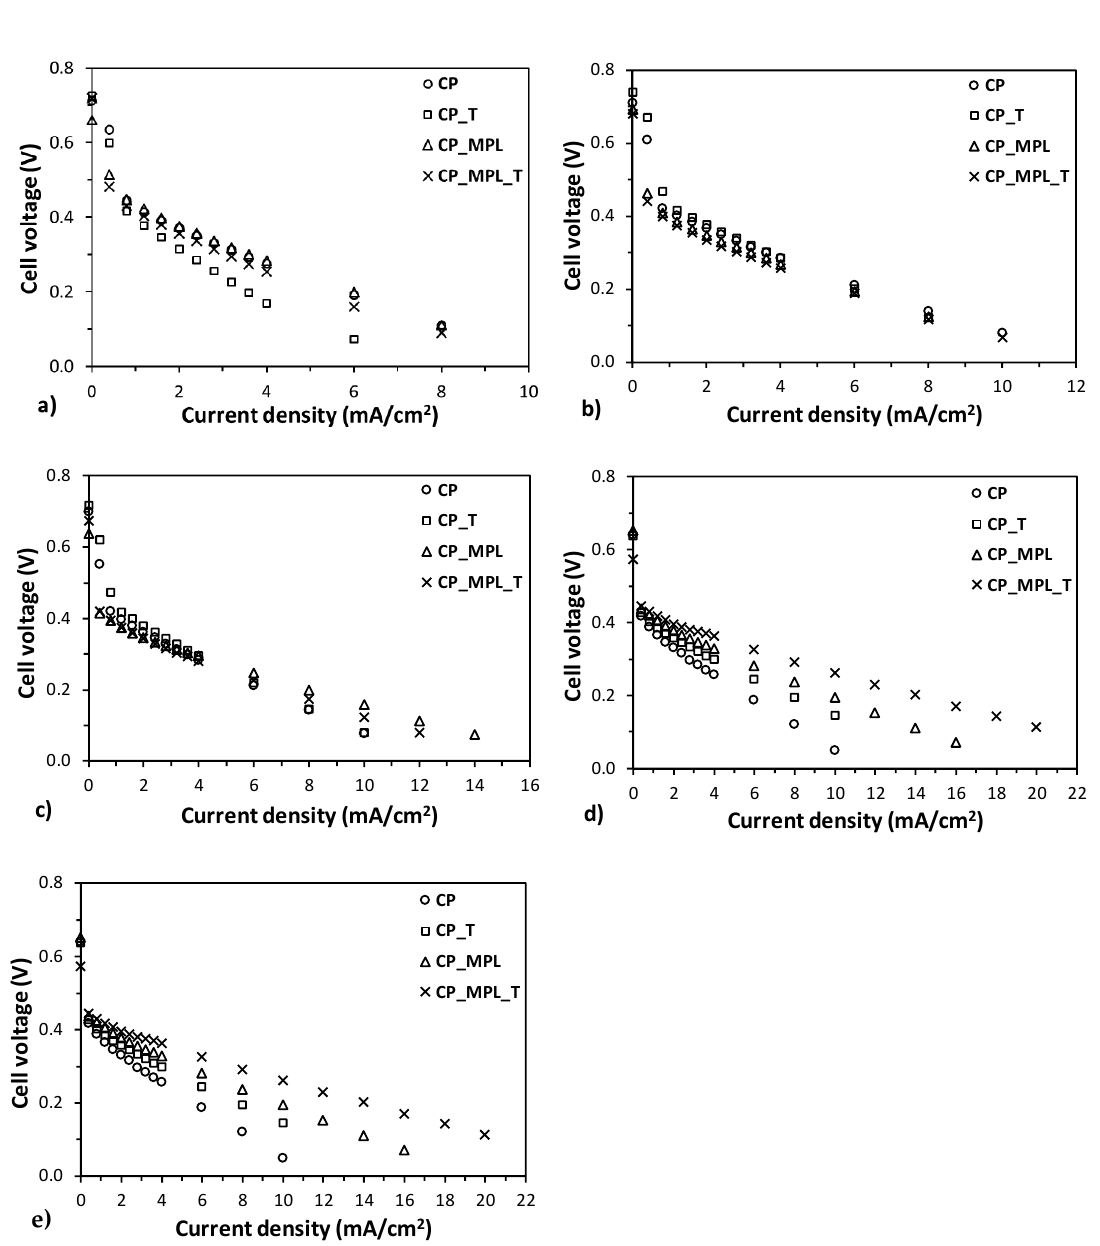
Figure 5. Effect of using carbon paper with different properties as ADL on the cell performance; methanol concentrations: ( a ) 1 M, ( b ) 2 M, ( c ) 3 M, ( d ) 5 M, and ( e ) 7 M.